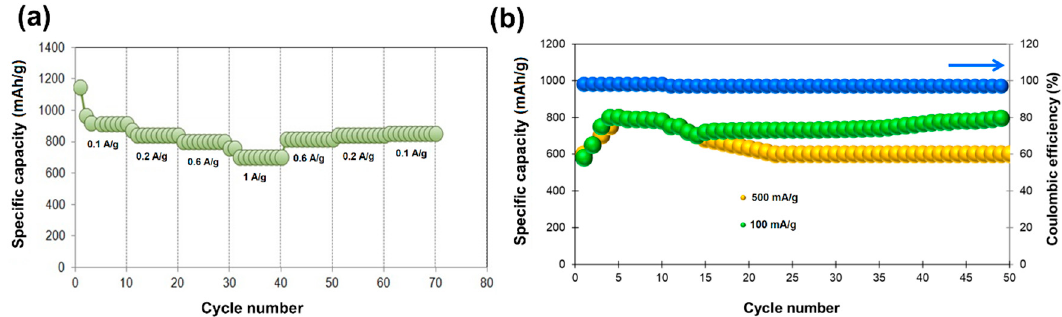
Figure 8. Rate capabilities of MoO 3 from 100 to 1000 mA/g ( a ); discharge capacities and coulombic efficiencies of MoO 3 ( b ).